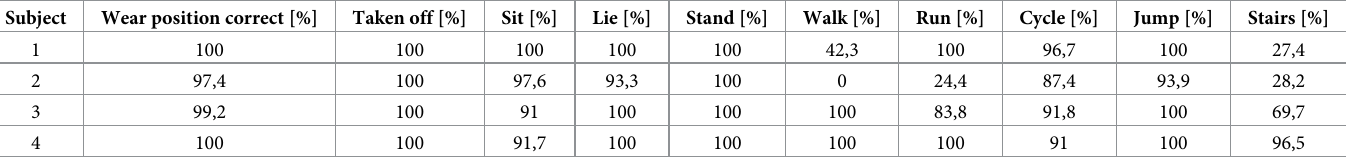
Table 3. Individual results of the proof-of-concept study with four healthy